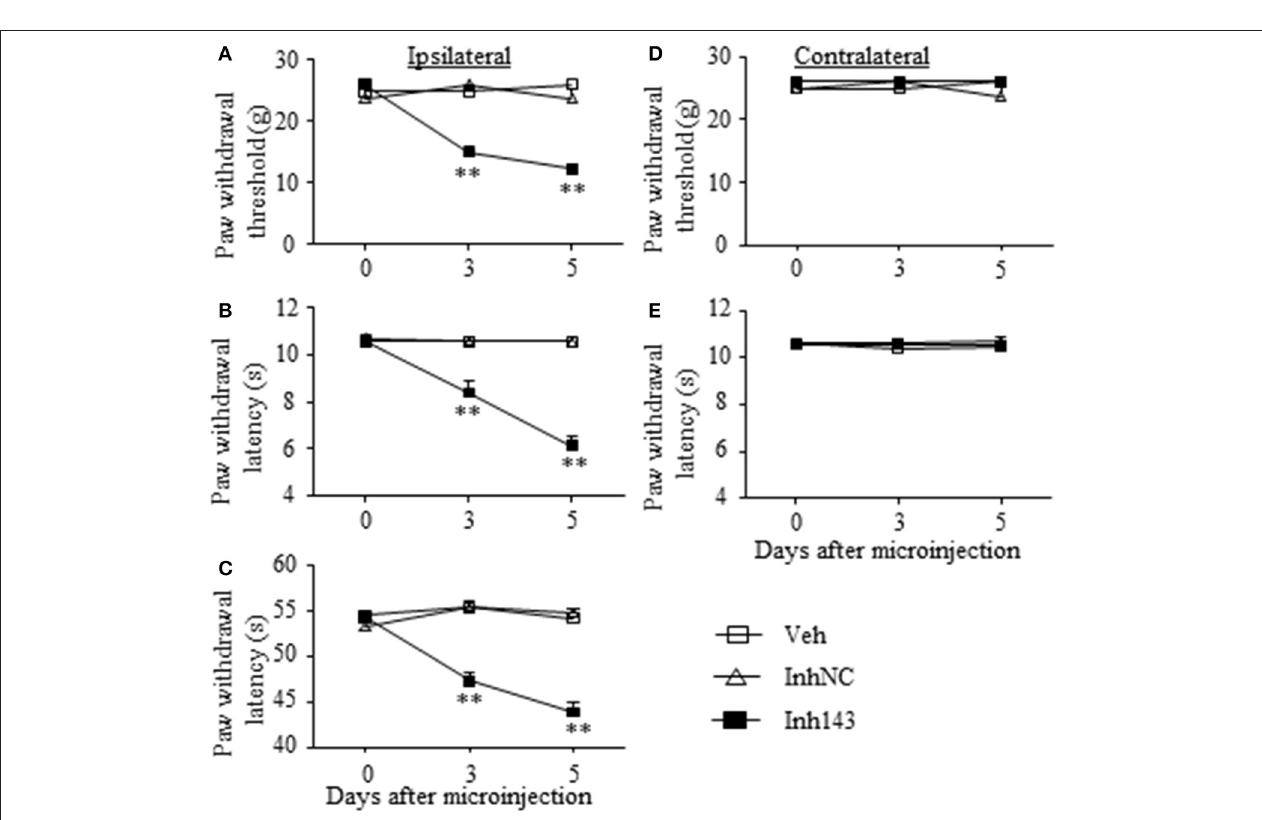
FIGURE 6 | miR-143 knockdown caused by DRG microinjection of miR-143 inhibitors produced neuropathic pain-like symptoms in naive rats. Paw withdrawal responses to mechanical (A,D) , thermal (B,E) and cold (C) stimuli on the ipsilateral (A–C) and contralateral (D,E) sides from the treated groups as shown. Inh143, miR-143 inhibitors; Inh NC, inhibitor negative control; Veh, vehicle; n = 5 rats/group. Two-way ANOVA followed by Tukey post-hoc test. ** P < 0.01 vs. the vehicle group at the corresponding time point.